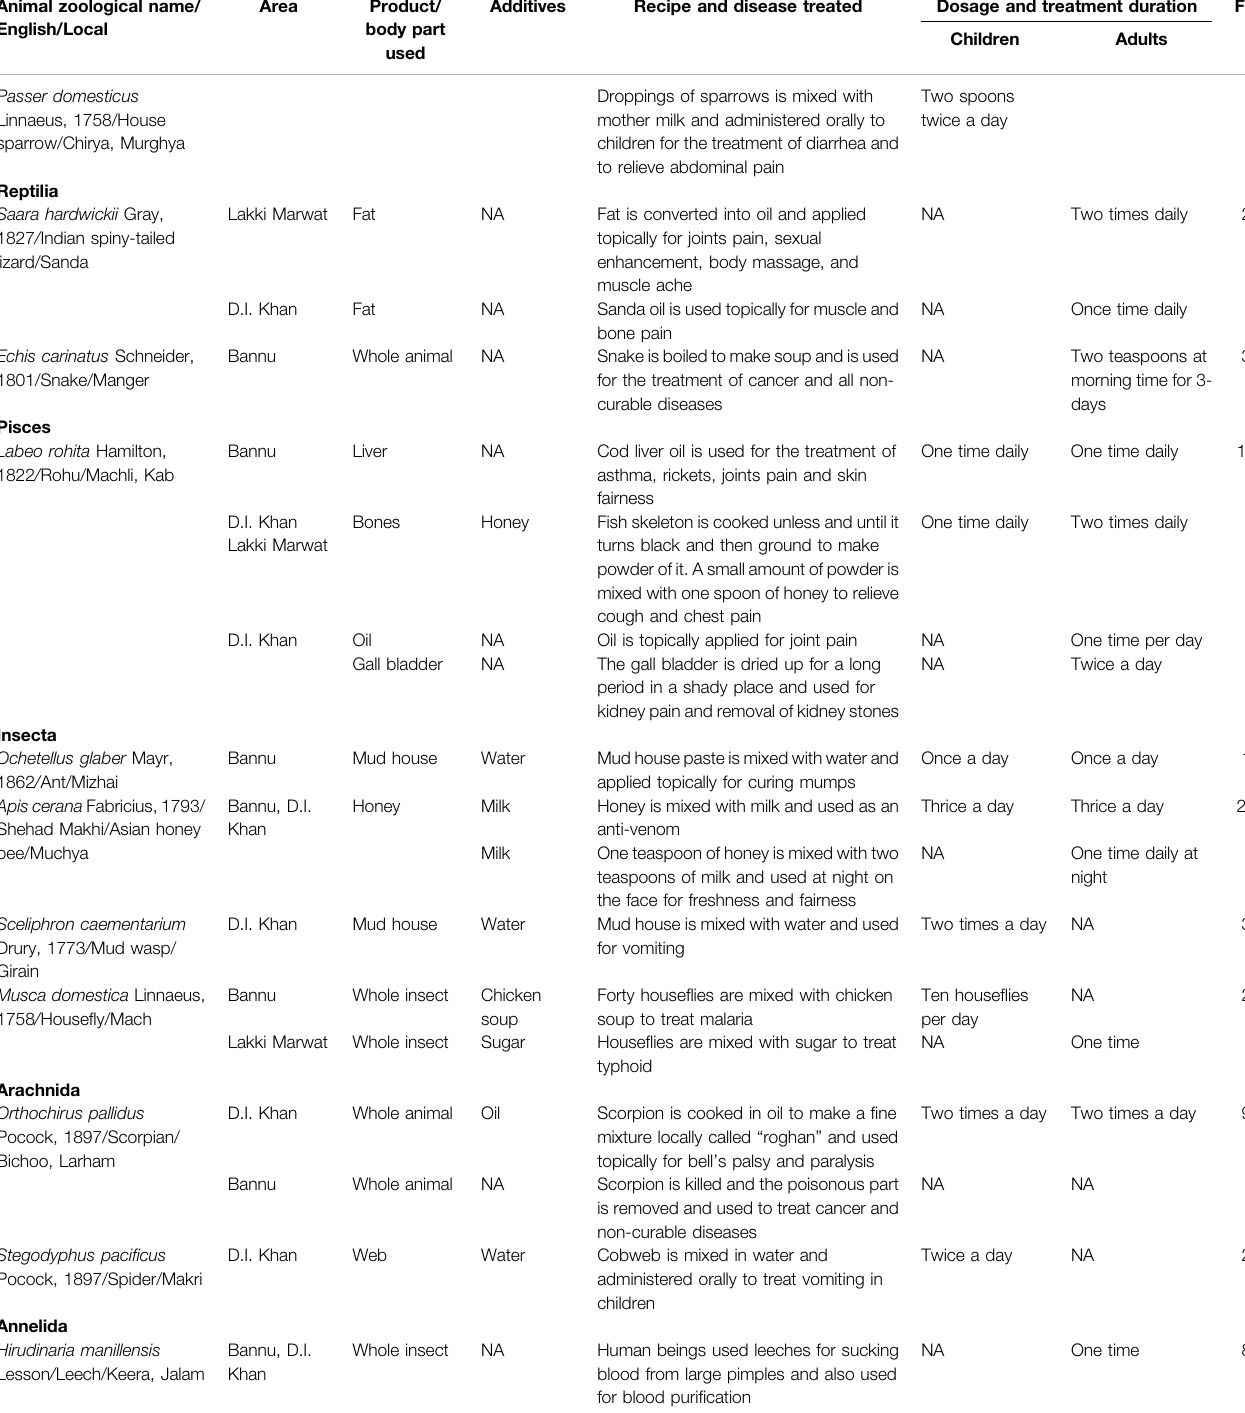
TABLE 2 | ( Continued ) Medicinal uses of animal species and their body parts/products in southern regions of Khyber Pakhtunkhwa (Pakistan). Animal zoological name/